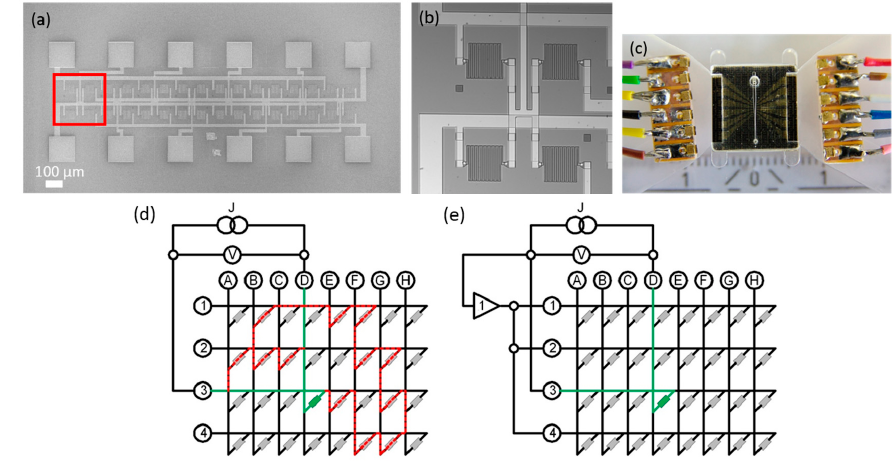
Figure 12. Lab-prototype of a “lab on a chip” device: ( a ) SEM image of the device heart consisting of 32 GMR sensors. The marked region of four meander shaped GMR sensors is shown enlarged in ( b ); ( c ) Photograph of the connected device; ( d , e ) illustrate the advantage of the guarding procedure for an analysis of a matrix of 32 sensors. Only the green labeled sensor element (line 3, column D) should be measured. Possible other paths of the current are marked in red; ( d ) the matrix without guarding; ( e ) when the guarding approach is applied.